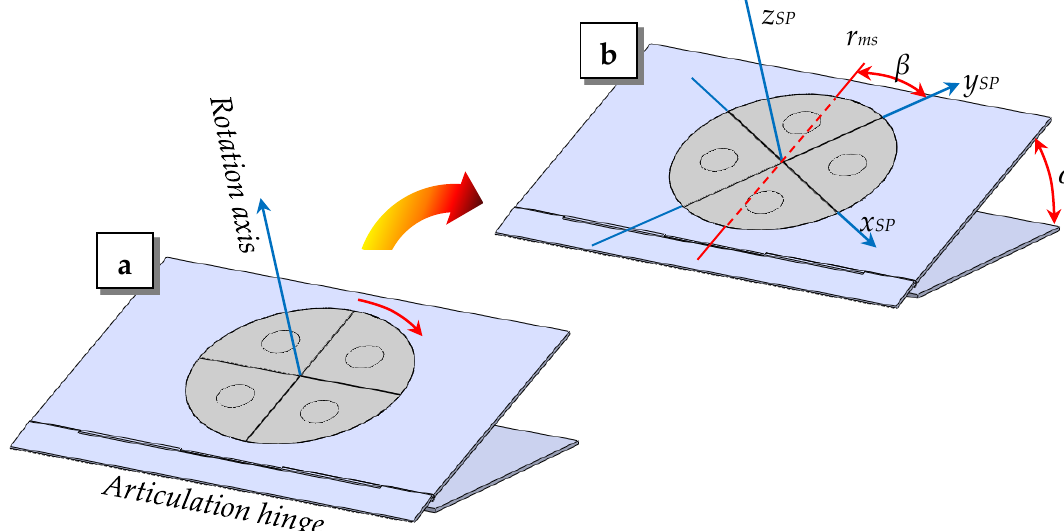
Figure 1. Embodiment design of the inclinable turntable, useful to present the main features that this test rig has (( a ) with only the support plane inclined; ( b ) with the support plane inclined and after a rotation of the rotating subsystem). In the same picture the reference frame x SP -y SP -z SP - CoR, fixed to the turntable (NB: di ff erent from the reference frame of the vehicle placed on it) and the operative angles α and β are also visible.